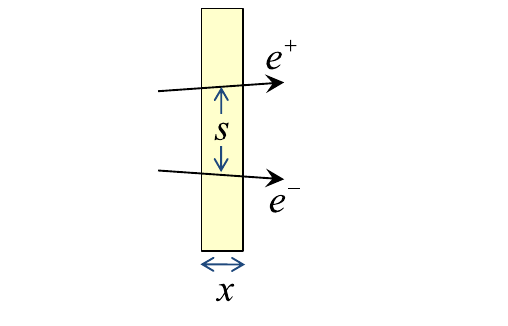
Fig. 1 Penetration of the target by the pair potential of the pair in a polarized medium. The